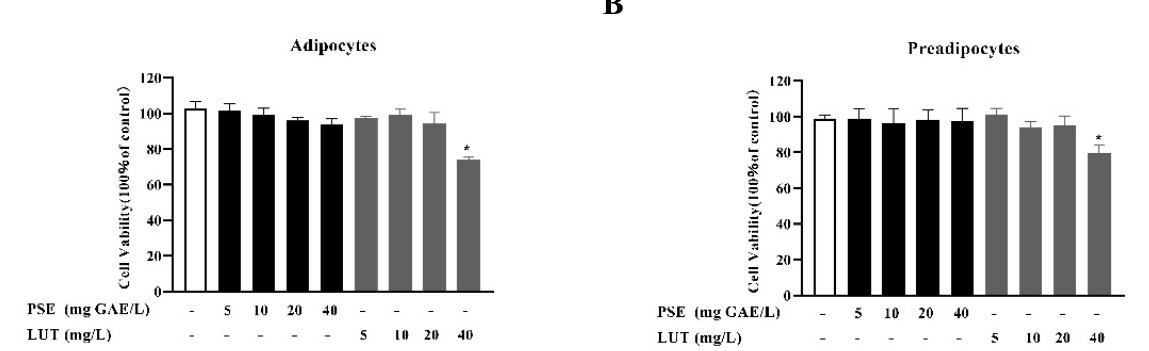
Figure 1. The cell viability of the 3T3-L1 cells in the ( A ) preadipocytes and ( B ) adipocytes treated with PSE and LUT or a vehicle 48 h after cell plating. Data are presented as mean ± SD from three independent experiments. * Significant differences are indicated by p < 0.05.